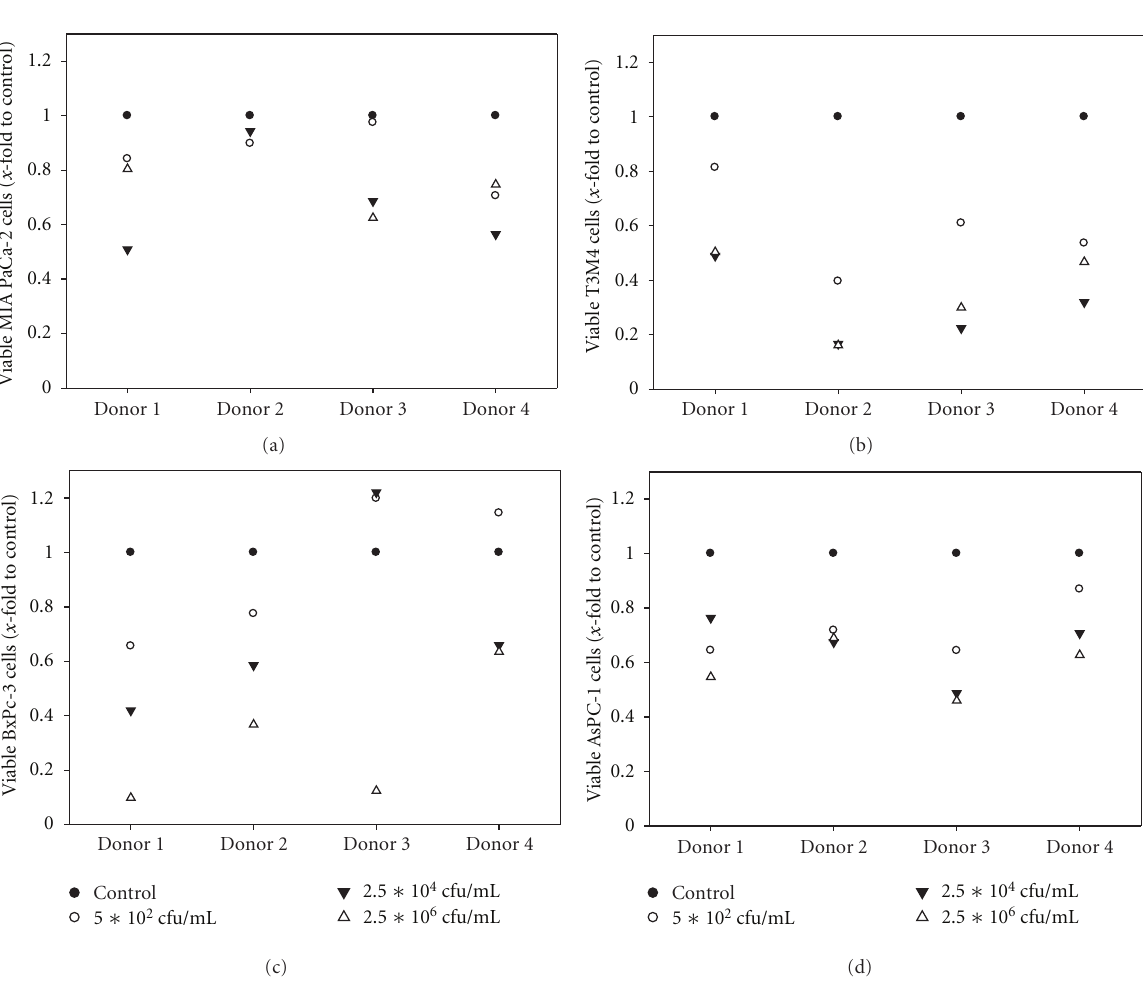
provided by S. pyogenes (i.e., streptokinase, streptolysin, and lipoteichoic acid) led to apoptosis [1, 16, 19,